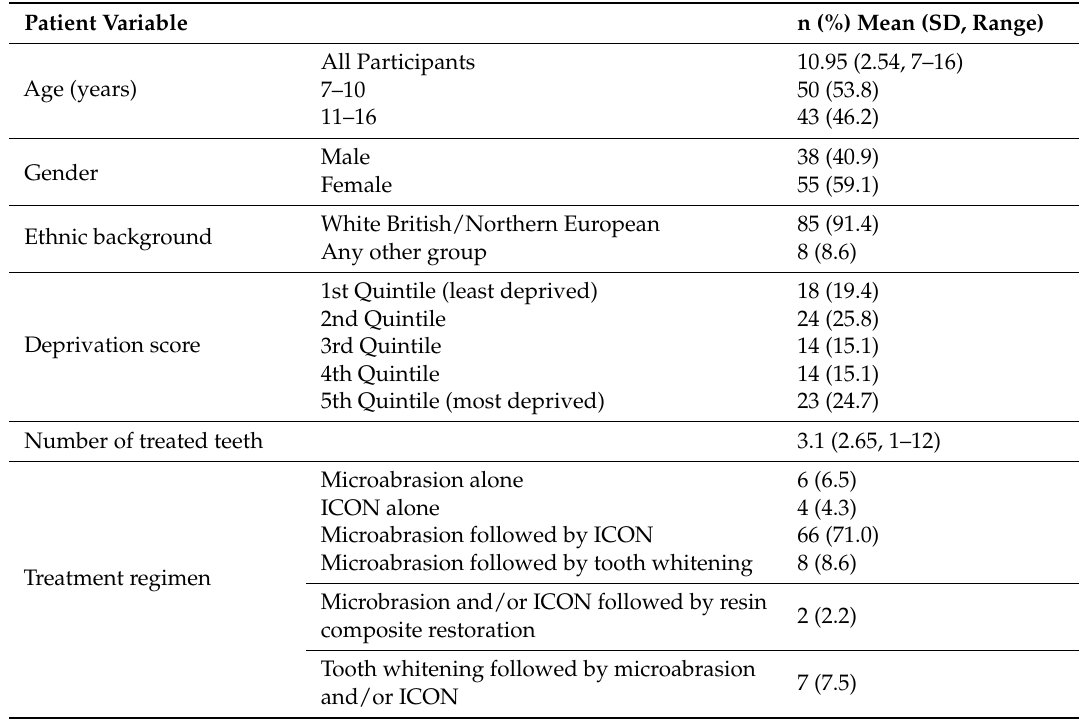
Table 1. Sociodemographic and clinical characteristics of study participants (n =